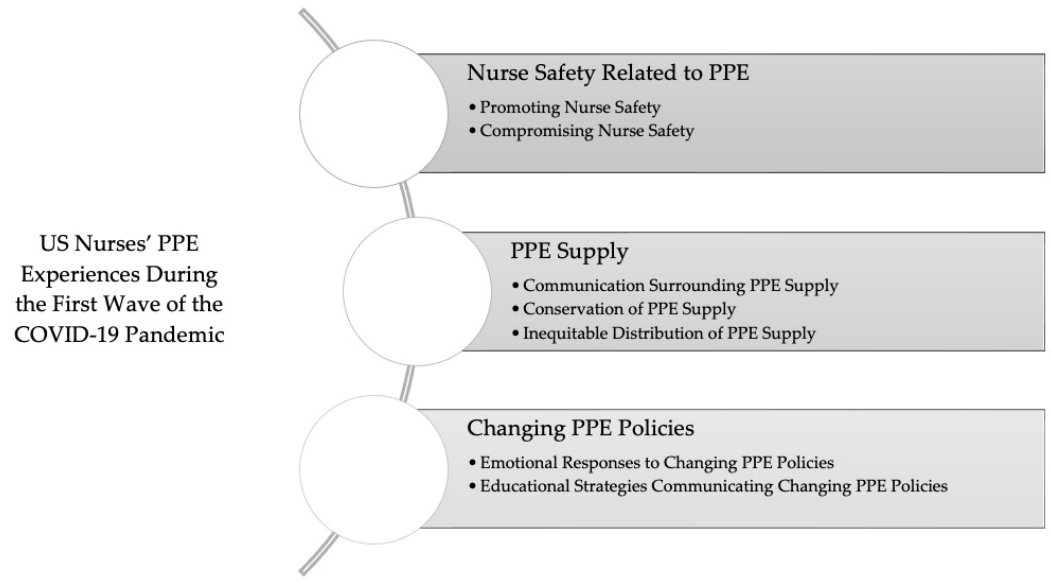
Figure 1. Nurses’ PPE Experiences Conceptual Framework. Table 2. PPE Themes and Illustrative Quotes.